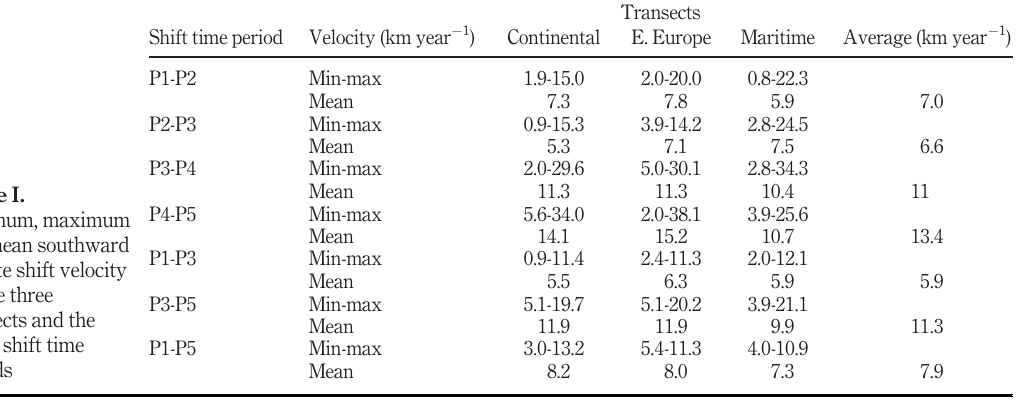
Table I. Minimum, maximum and mean southward climate shift velocity for the three transects and the seven shift